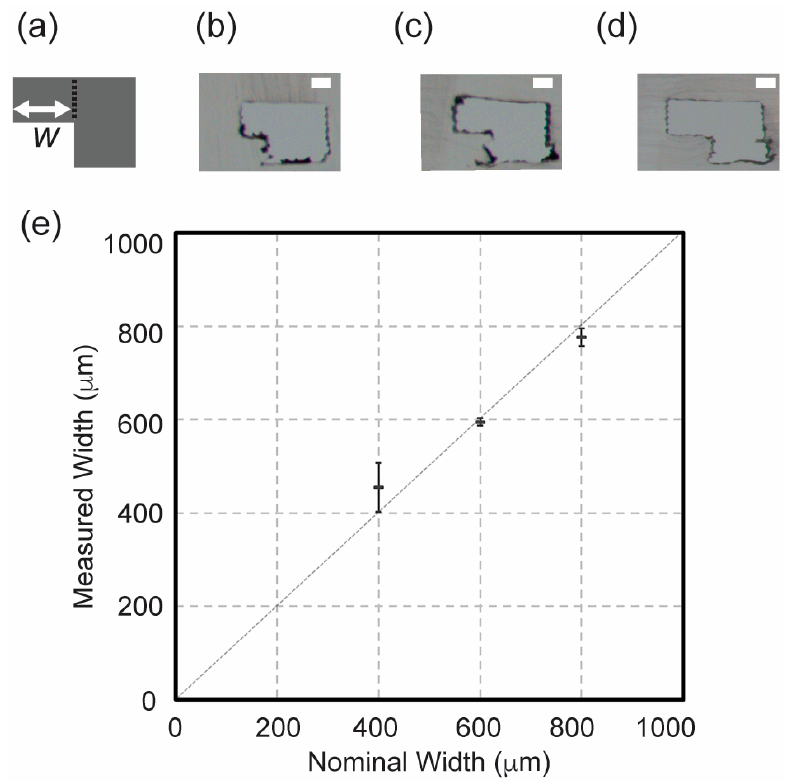
Figure 3. Characterization of the width of the overhangs in the serpentine microchannel fabricated by dual extrusion of HIPS and PVA. ( a ) Schematic showing a cross section of the overhang feature that was studied. The width of the overhang of the microchannel ( w ) was characterized. Representative images of cross sections of overhang features fabricated in PDMS with the overhang ( b ) 400 µ m, ( c ) 600 µ m, and ( d ) 800 µ m. ( e ) Characterization of the variation of the width of the fabricated overhangs with respect to the nominal width designed by CAD. The data are mean ± SD ( n = 10). Scale bar = 400 µ m. Since PVA is poorly soluble in most organic solvent [21], we postulated that limonene can be removed without damaging the PVA mold. The design of the PVA sacrificial mold defined the final outcome of the microchannel created in the PDMS matrix. The measurement of the width of the overhangs suggested that the dimension of PVA was not affected by the exposure to